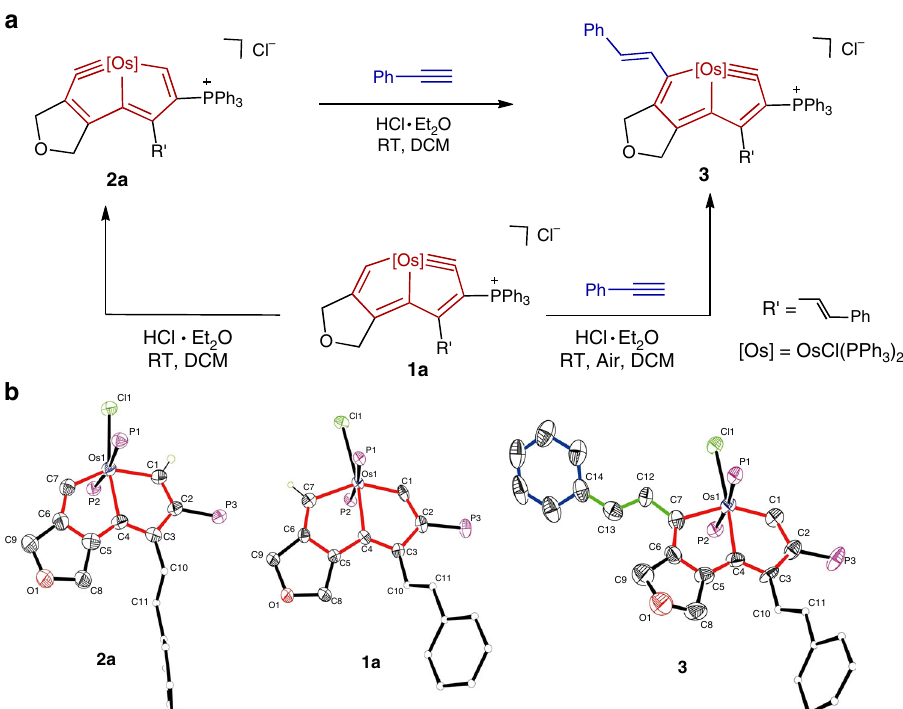
Fig. 1 Reactions of alkynes with osmapentalynes. a Reaction of alkynes and osmapentalynes and the reaction of carbyne triple bond shifted reaction. b X- ray molecular structure for the cations of complex 1a , complex 2a , and complex 3 . Ellipsoids are at the 50% probability level; phenyl groups in PPh 3 are omitted for